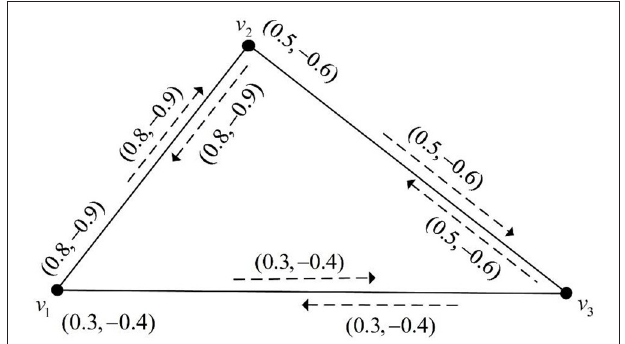
FIGURE 1 | A bipolar fuzzy incidence graph G with WI BFI ( G ) = ( WI P BFI ( G ), WI N BFI ( G )) = (5.2, − 6) and WAI BFI ( G ) = 0.8. A bipolar fuzzy incidence graph G ′ is depicted in Figure 2 , we confirm that η ∗ = { v ′ 1 , v ′ 2 , v ′ 3 } ,